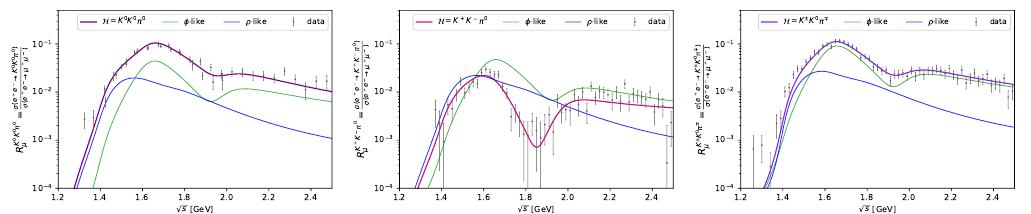
for H = K 0 K 0 π 0 (left), K + K − π 0 (middle), K ± K 0 π ∓ µ